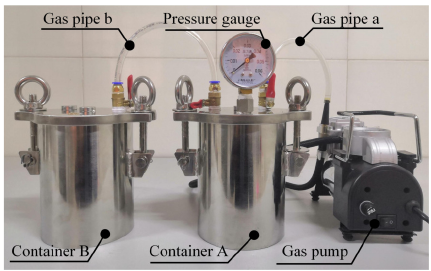
Figure 7. Void ratio determination test